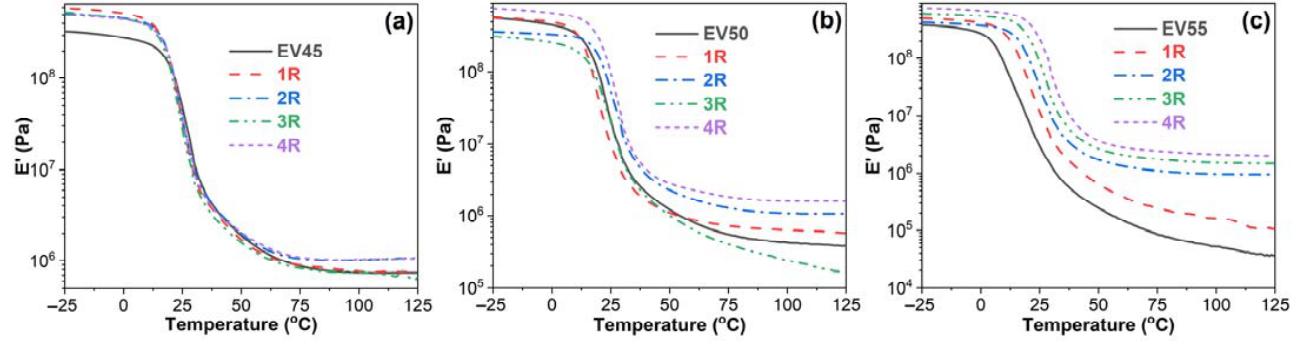
Figure 7. Storage modulus versus temperature curves of the original and recycled epoxy vitrimers: ( a ) EV45, ( b ) EV50 and ( c ) EV55.